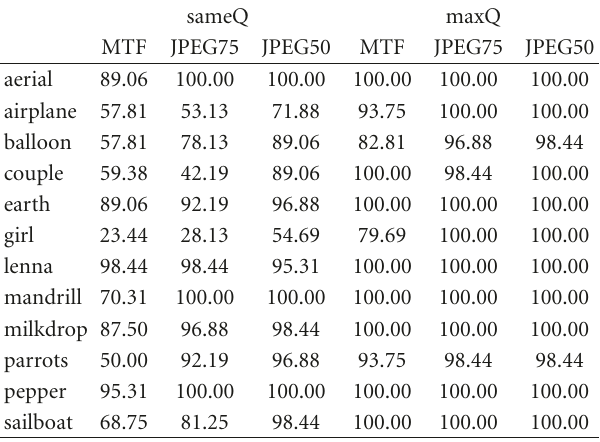
Table 7: Extraction rates in JPEG compression of quality